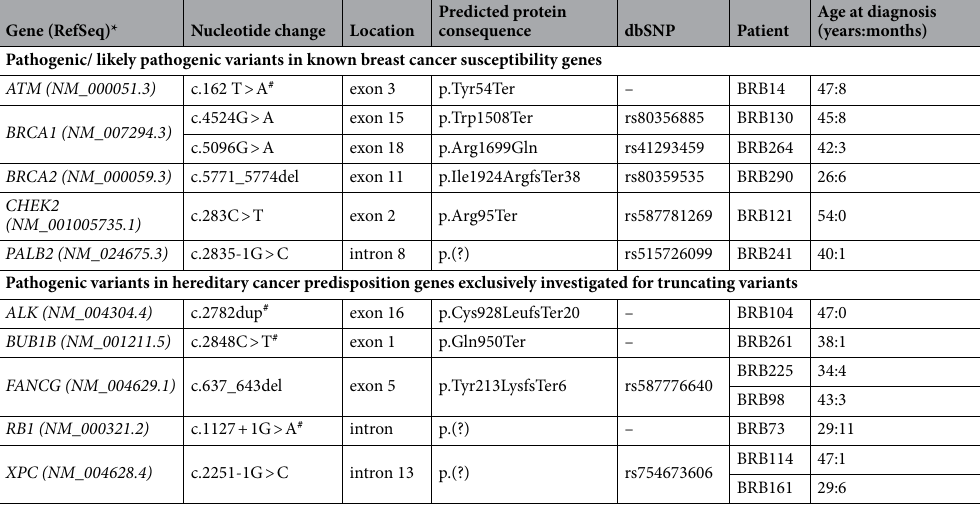
Table 1. Pathogenic/likely pathogenic variants detected in a South African breast cancer cohort of African ancestry. *Reference sequences obtained from the NCBI database. For BRCA1 the most common human transcript (NM_007294.3) was used with custom numbering of the exons (missing exon 4). Variant nomenclature according to the Human Genome Variation Society (HGVS) where complimentary DNA (cDNA) numbering + 1 corresponds to the A of the ATG translation initiation codon. # Not reported in dbSNP (http:// www. ncbi. nlm. nih. gov/ SNP), EVS (http:// evs. gs. washi ngton. edu/ EVS), gnomAD (https:// gnomad. broad insti tute. org) or ClinVar (https:// www. ncbi. nlm. nih. gov/ clinv